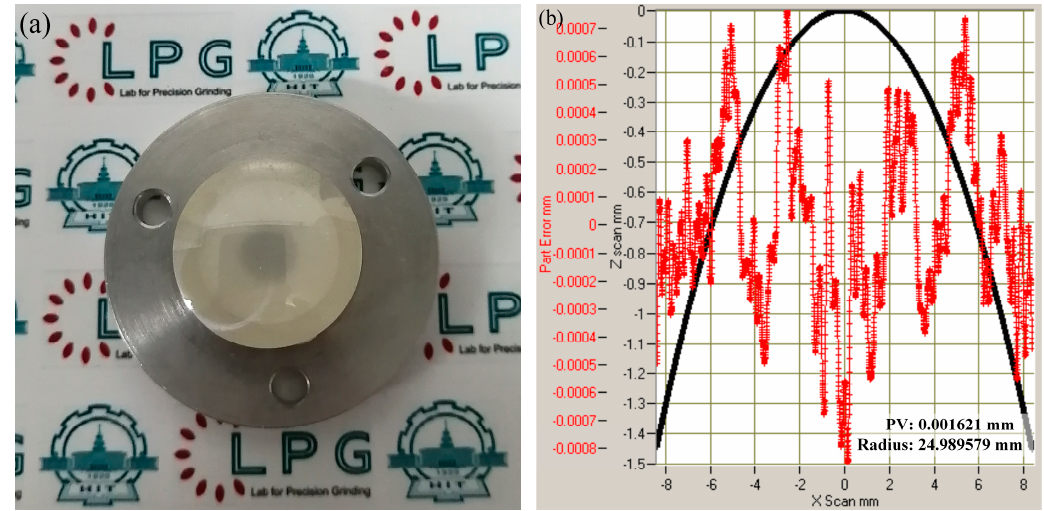
Figure 12. Grinding results of the ZnS test workpiece: ( a ) grinding surface, ( b ) surface form error.